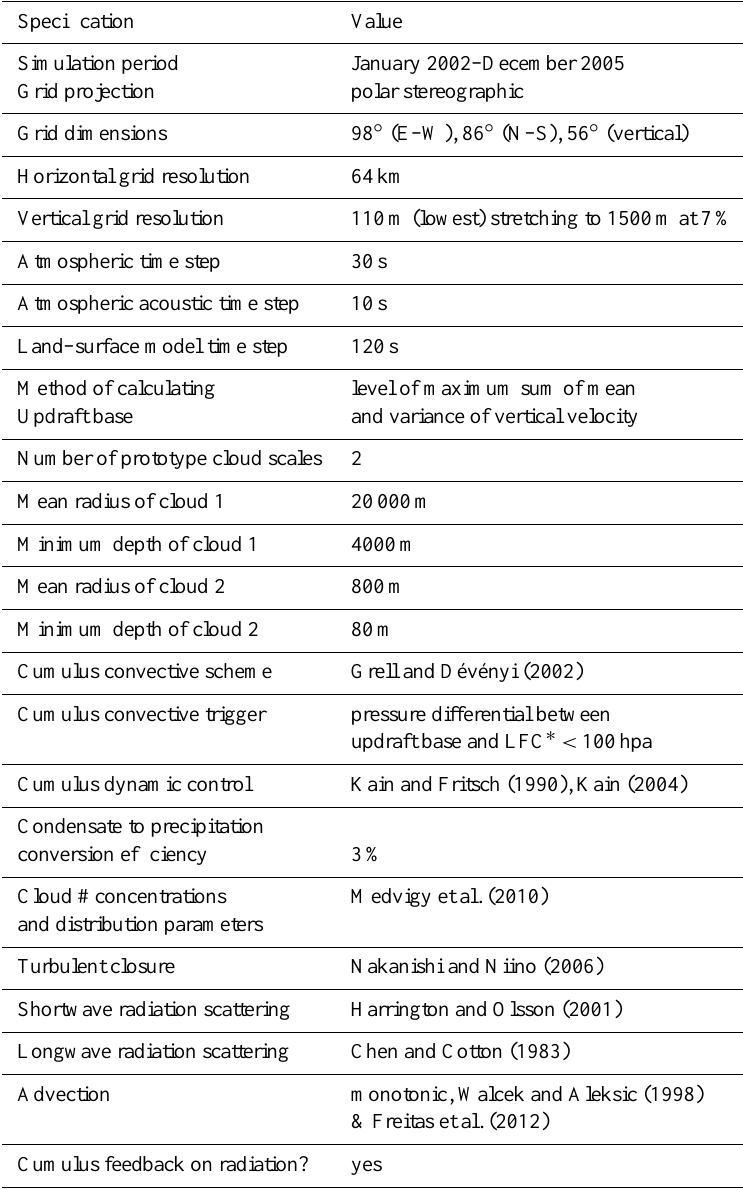
Table 2. Run time parameters and specifications in the ED2-BRAMS coupled